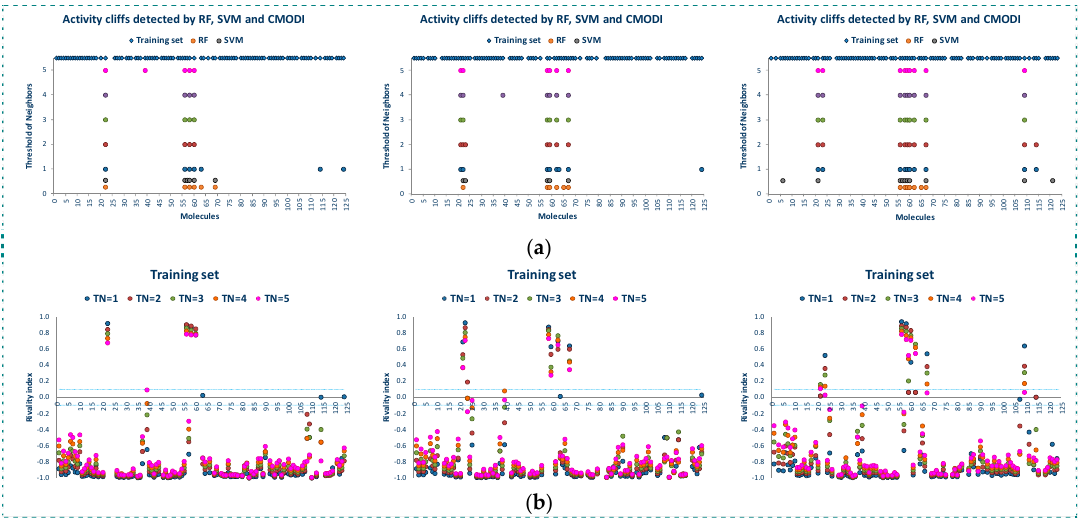
Table 2. Results of the predictions using CMODI for different values of TN and the algorithms for the three whole training sets and the training sets erasing the activity cliffs detected for TN = 3.